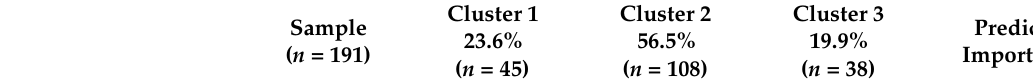
Table 3. Cognitive and affective attitudes of